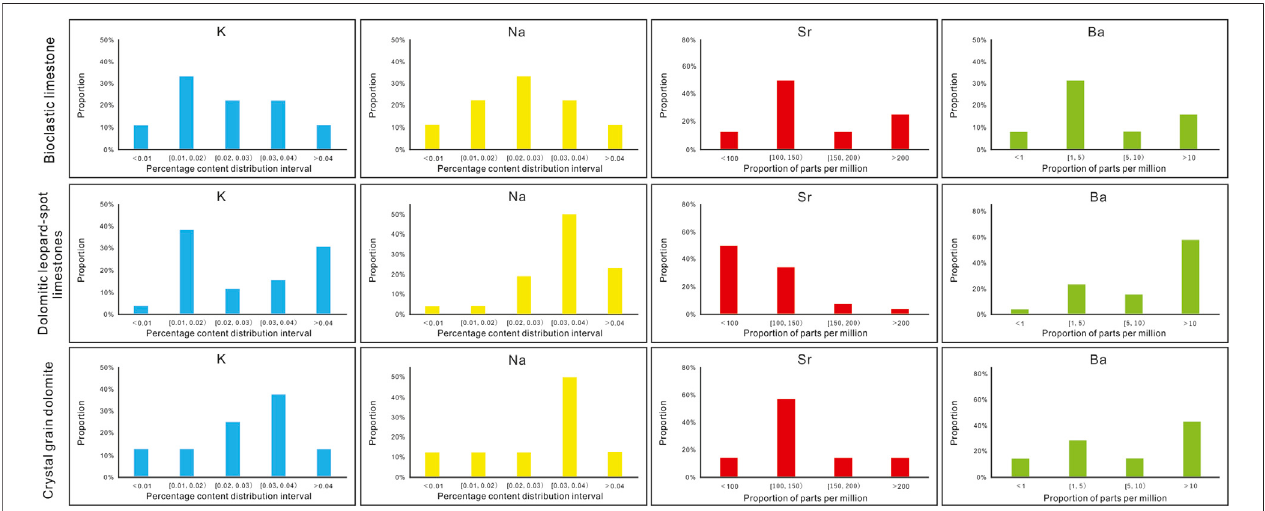
FIGURE 4 | Statistical charts of the contents of K, Na, Sr, and Ba in dolomites of the Qixia Formation in the study area.